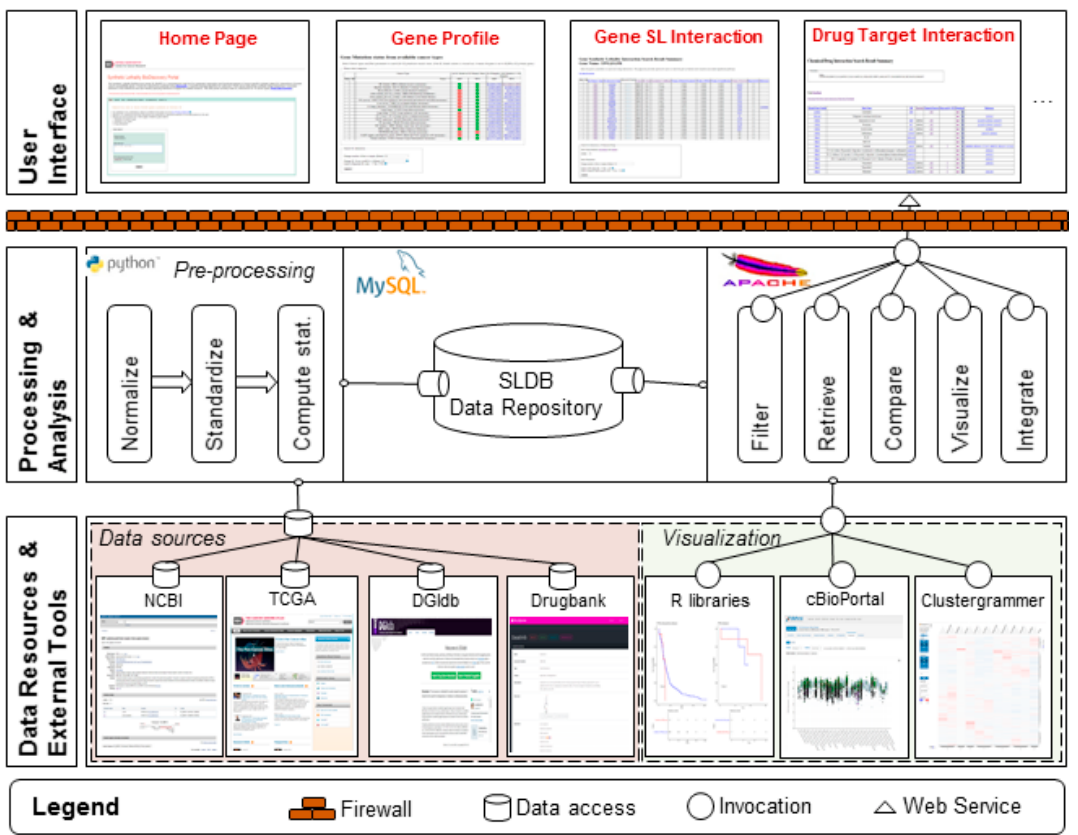
Figure 5. SL-BioDP overall architecture. Runtime overview showing the 3-tier architecture design. The lower tier represents the sources of data, annotations, drug data, and external tools that are invoked to visualize the data. The middle tier represents how the data are processed, stored, and made available to the user. The right-hand side of middle tier shows the visualization services available to user during runtime. These services are made available as web services and are hosted on an Apache server. The top tier represents the user interface and is organized into multiple tabs.